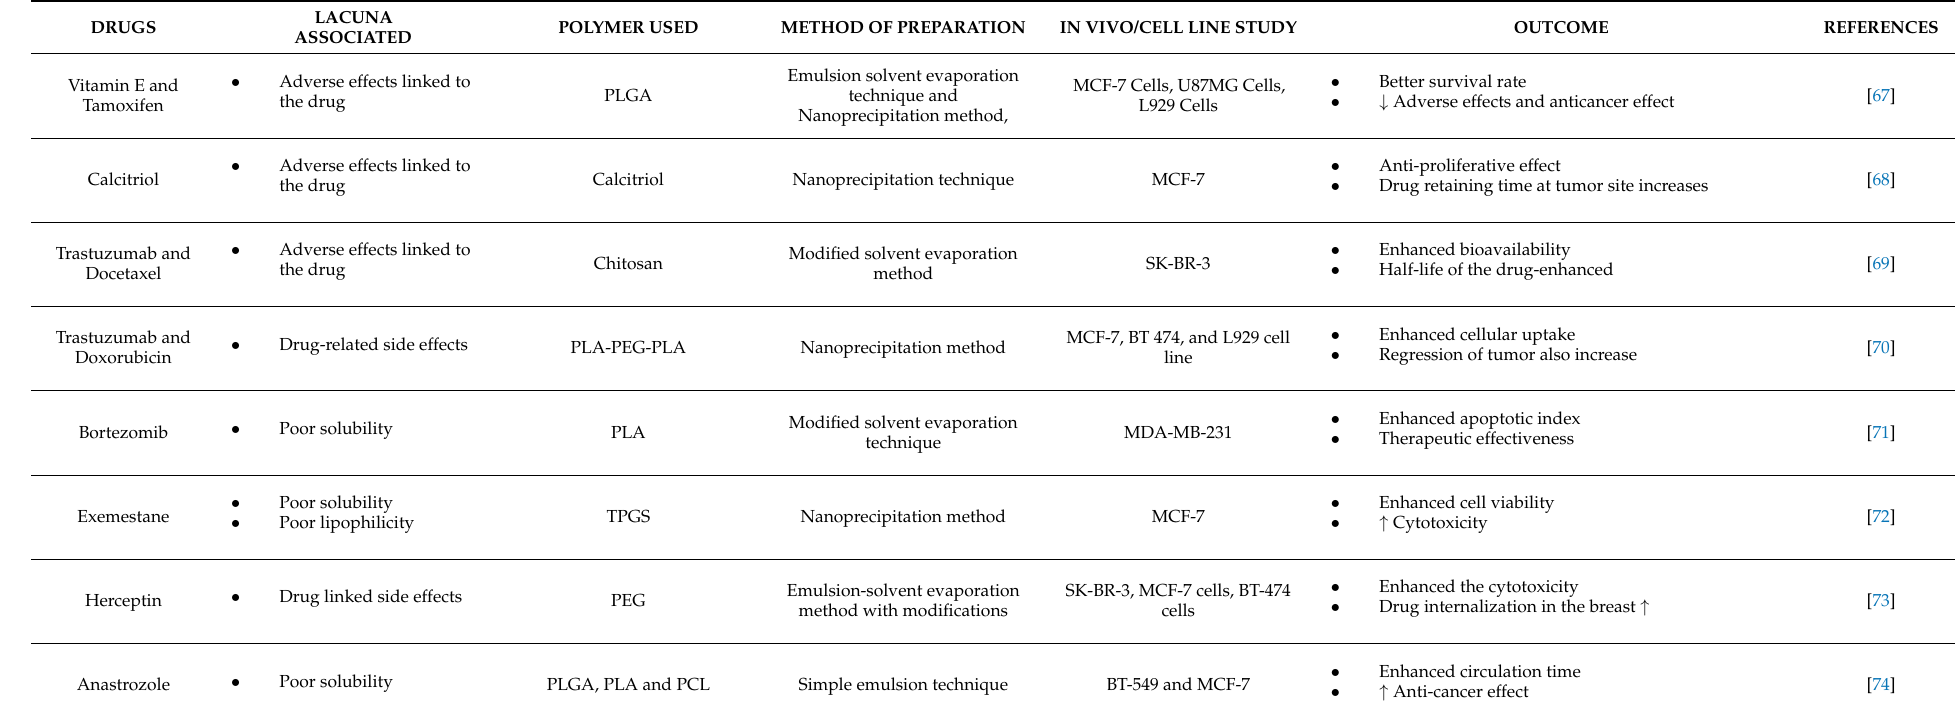
Table 5. Vitamins, Hormones, Phytoconstituents and their combination polymeric nanoparticles for breast cancer